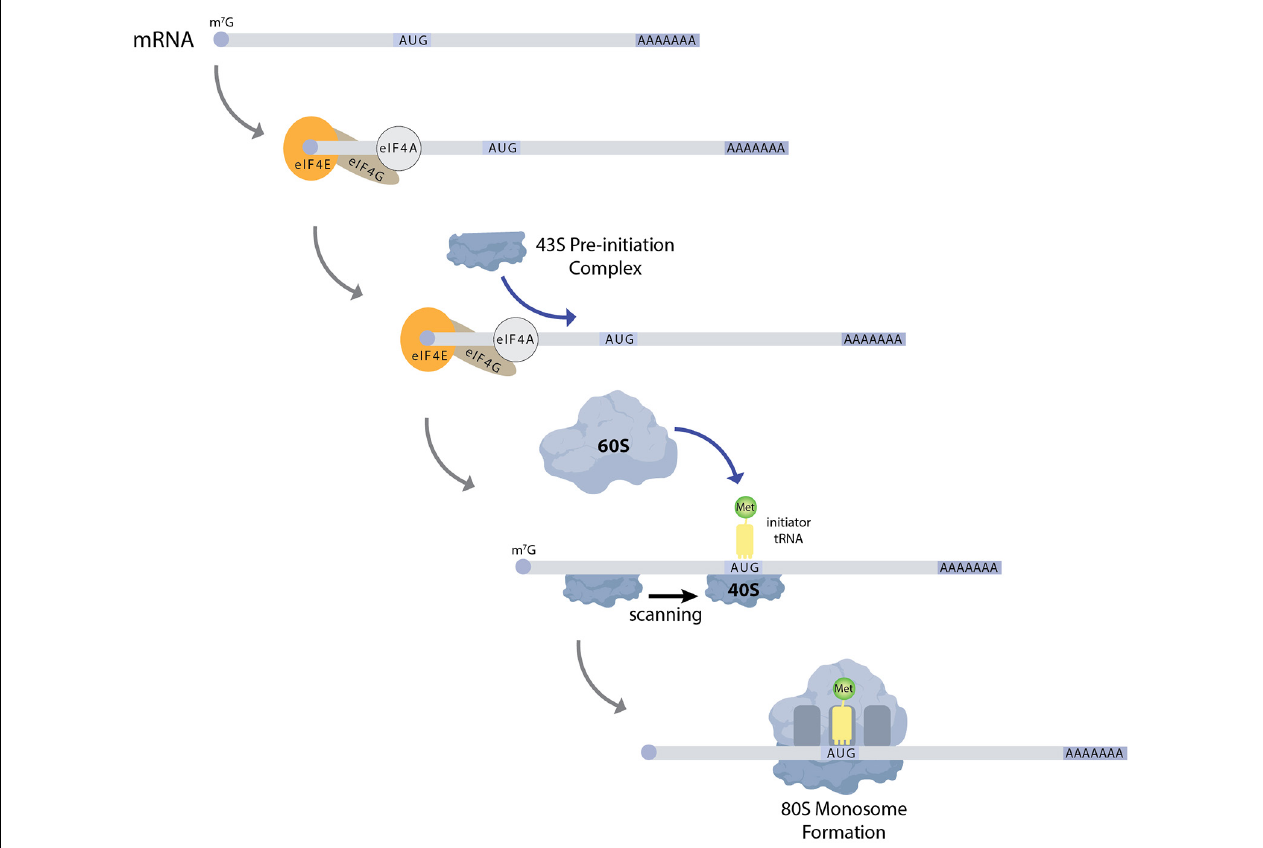
FIGURE 2 | Schematic of general translation initiation. mRNAs generally have a 7-methylguanosine cap and a poly-A tail. The cap serves to recruit the translation initiation factor eIF4E to mRNAs. eIF4E then recruits the scaffold protein eIF4G, which in turn brings the RNA helicase eIF4A to mRNA. eIF4A serves to unwind secondary structure within the 5 (cid:48) UTR of mRNAs, which allows for the recruitment of the 43S pre-initiation complex. This complex then scans the mRNA for a start codon, typically AUG. Next the 60S subunit is recruited to the mRNA to form a 80S monosome. Multiple ribosomes can associate with mRNAs to form